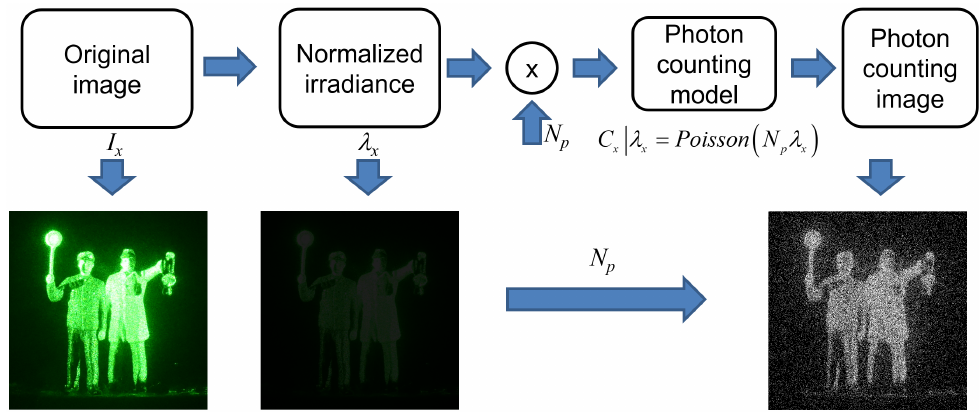
Figure 4. Procedure of computational photon counting